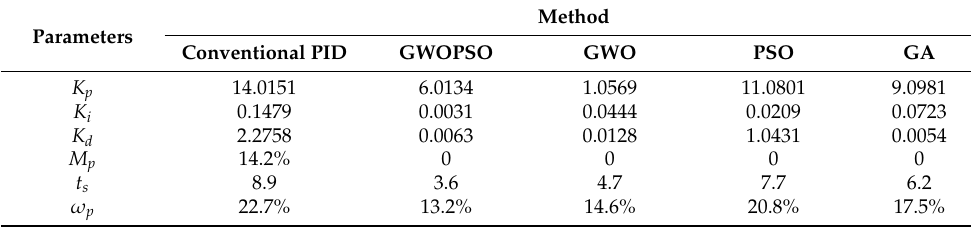
Table 7. PID parameters and dynamic response